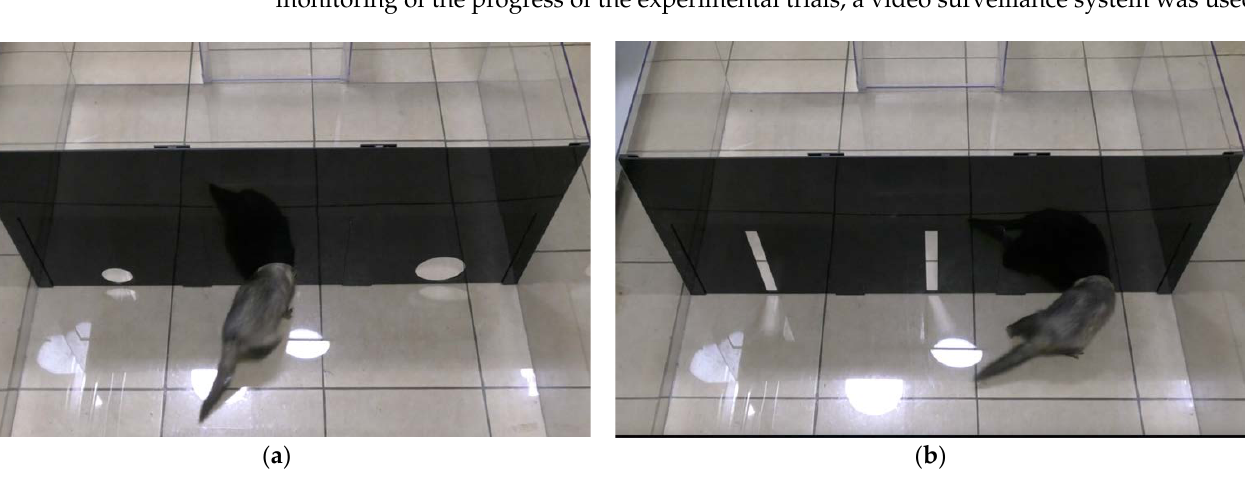
Figure 2. View of the experimental setup with ferrets: ( a ) a ferret enters the hole during Experiment 1; ( b ) a ferret enters a hole during Experiment 2. (Photo: